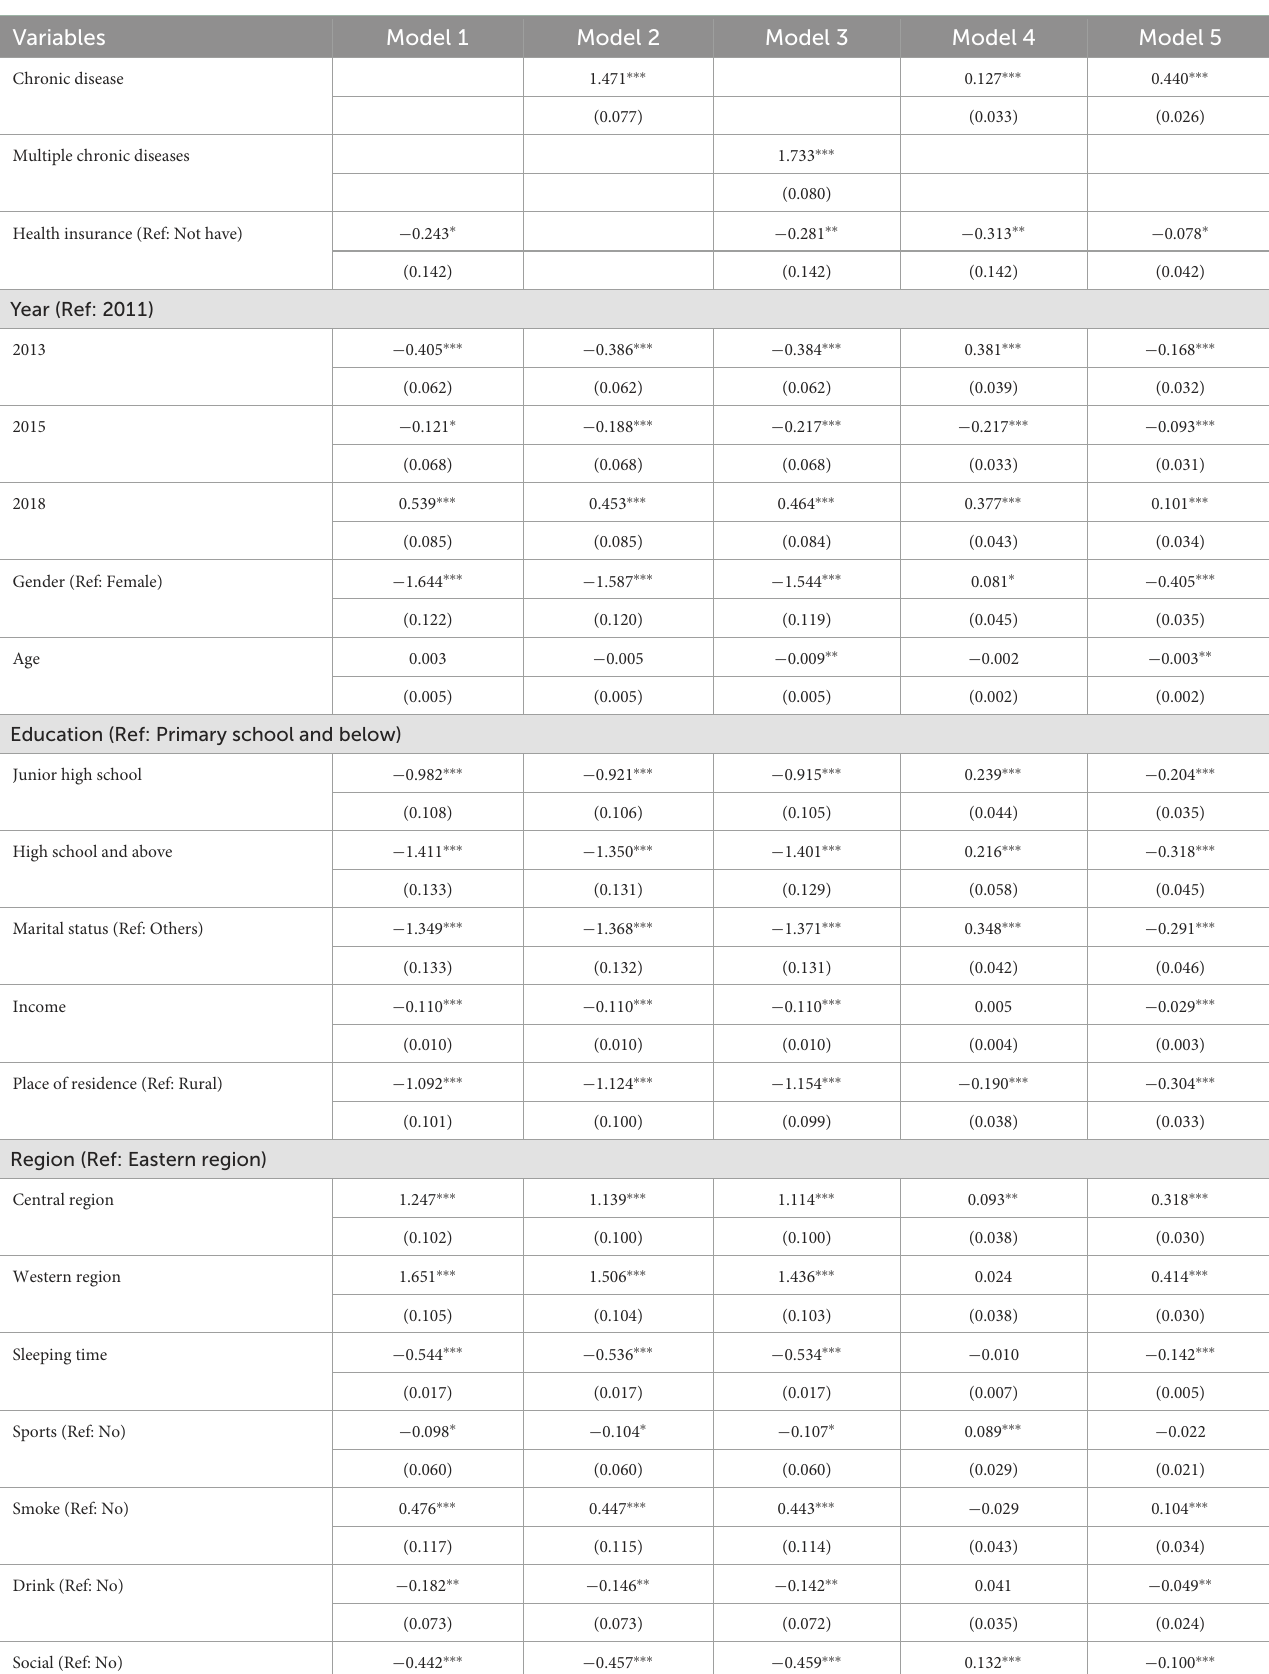
TABLE 3 Analysis of the influence of chronic disease on